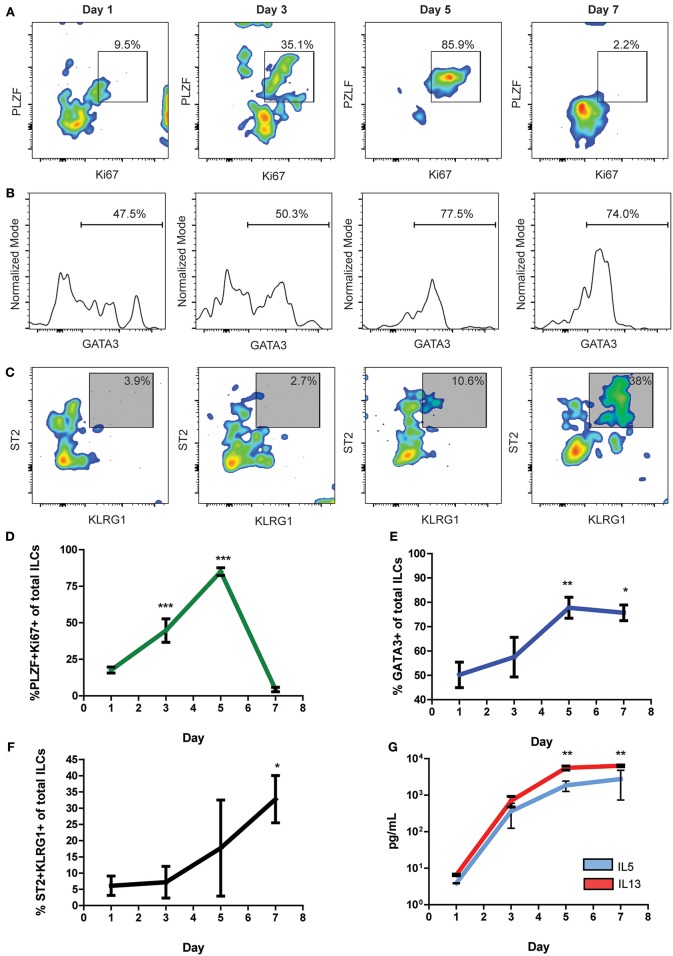
Undifferentiated naïve cardiac ILCs transiently express PLZF upon activation. (A) Timeline of PLZF+Ki67+ activation pattern under in vitro ILC2-differentiating conditions, IL-2+IL-7+IL-33. (B) Progression of GATA3 expression, showing the gate of GATA3+ ILCs. (C) Time course of ILC2 phenotype development, based on KLRG1 and ST2 co-expression. (D) Graph representing the evolution of the PLZF+Ki67+ co-expression. (E) Timeline of GATA3 expression during in vitro IL-33 stimulation. (F) Time curve showing the progression of ILC2 phenotype development. (G) Curve showing the evolution of IL-5 (blue) and IL-13 (red) production under IL-2+IL-7+IL-33 stimulation, as measured by ELISA of supernatants. Graphics show results of 1 of 2 independent experiments, each one made in triplicates for each condition. Asterisks represent the statistical significance of each time-point with respect to day 1-baseline values. Dots and whiskers show Mean and SD. Statistics calculated with one-way ANOVA and Bonferroni post-test. *P < 0.05; **P < 0.01; ***P < 0.001.